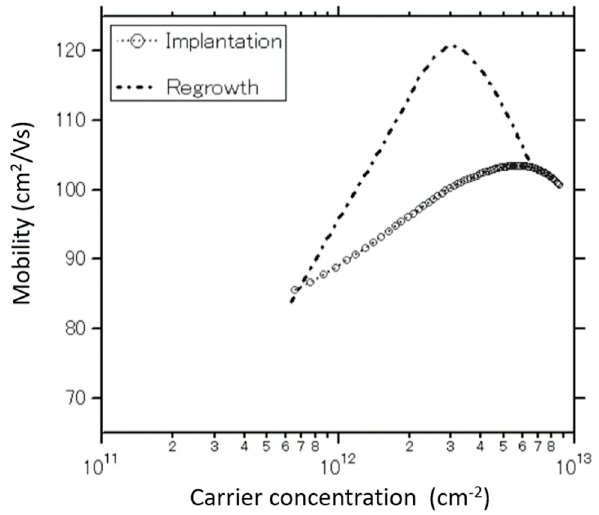
Figure 8. Electron mobilities in MOSFETs fabricated using the regrowth and implantation method.